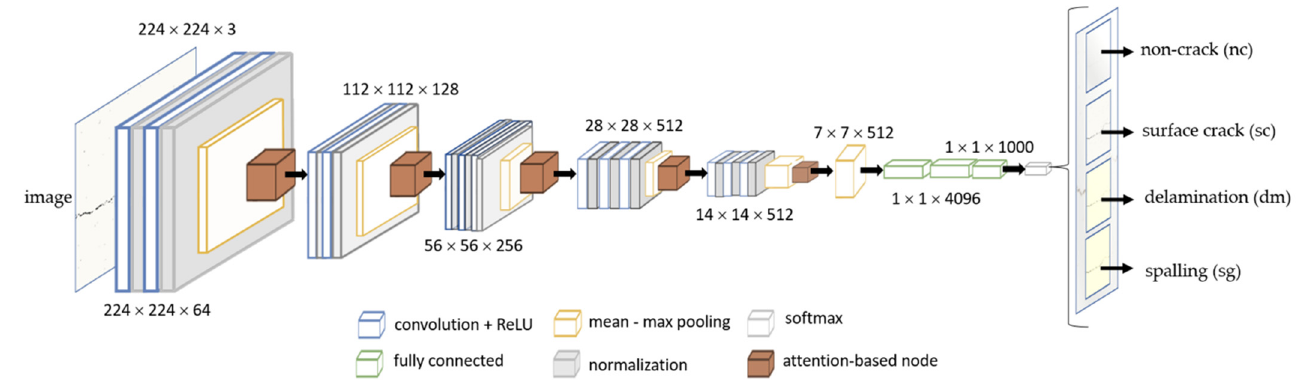
Figure 9. The proposed model structure using a multivariant defect recognition neural network. Integrated Max–Mean Pooling